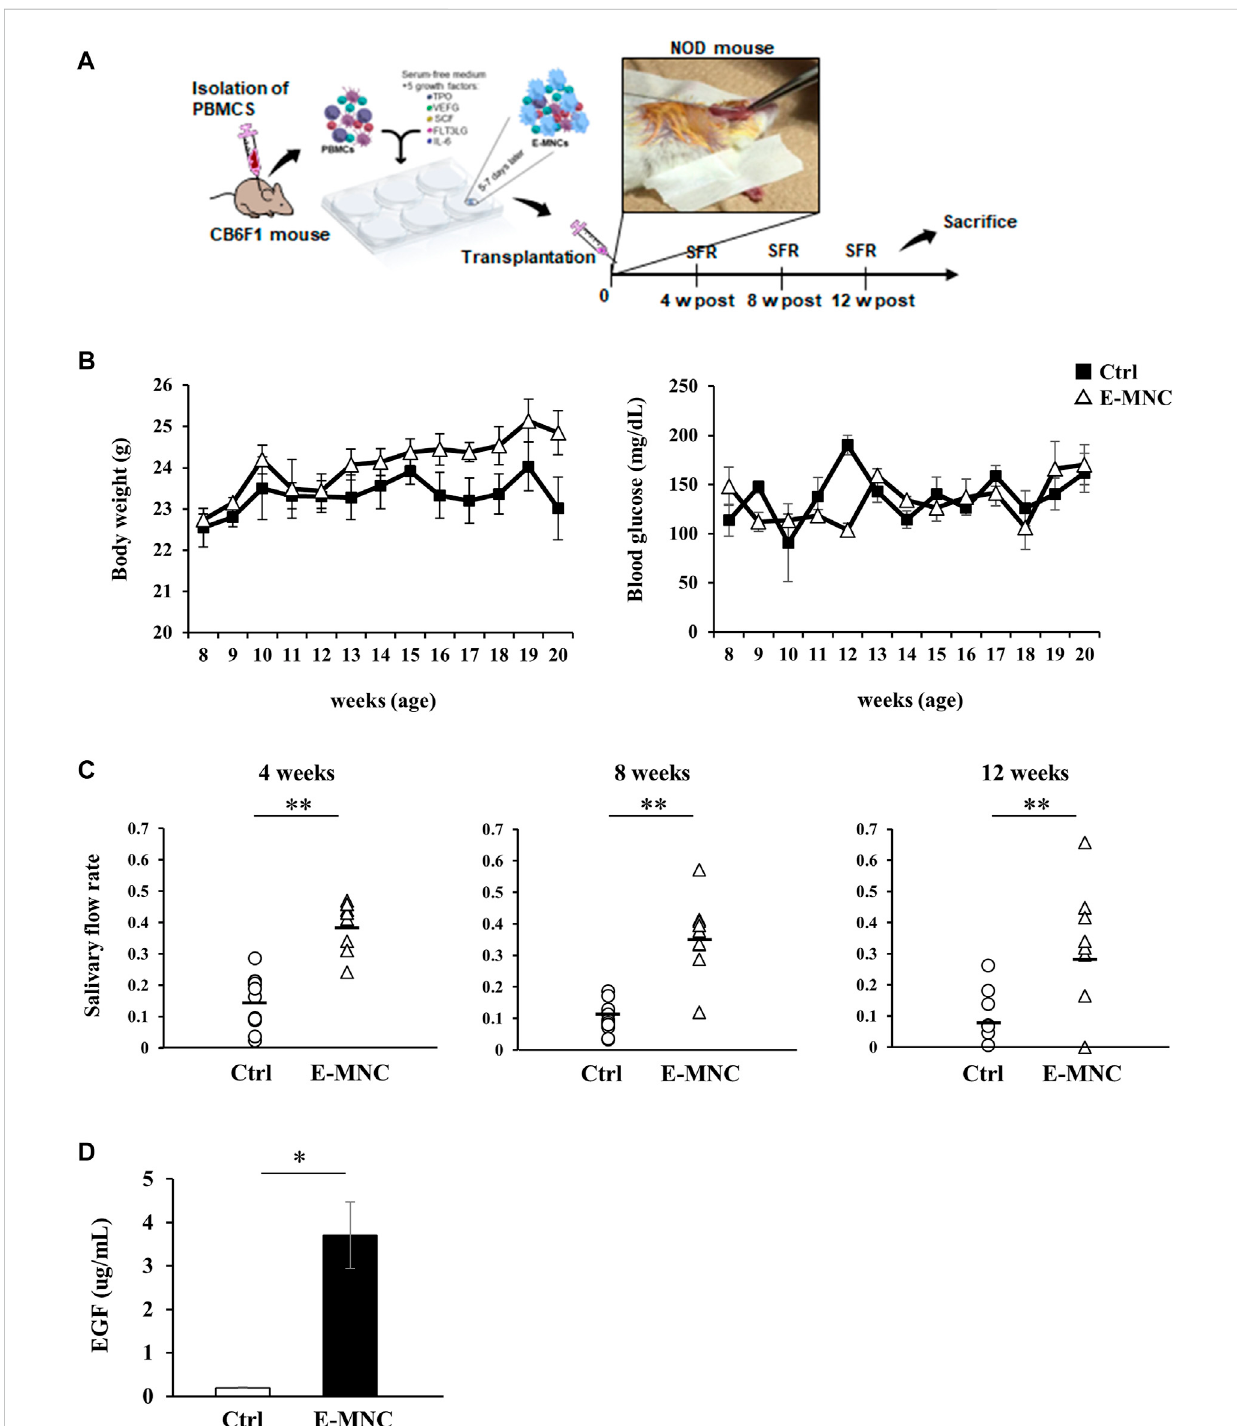
FIGURE 5 Transplantation of E-MNCs into NOD mice at the onset of SS-like disease. (A) Schematic diagram describing the experimental design for E-MNC transplantation. E-MNCs were injected into the submandibular glands directly, and then saliva and saliva glands were harvested at 4, 8, and 12 weeks. (B) Changes in body weight and blood glucose of non-treated mice (Ctrl) and E-MNC – treated mice (E-MNC). (C) Change in saliva production (salivary fl ow rate;SFR)at4,8,and12 weekspost-transplantation(** p < 0.01). (D) EGFconcentrationinsalivaofnon-treatedmice(Ctrl)andE-MNC – treatedmice (E-MNC) at 12 weeks post-transplantation (* p < 0.05). For statistical analysis, the Student ’ s t-test was performed to determine the signi fi cance of differences among Ctrl- and